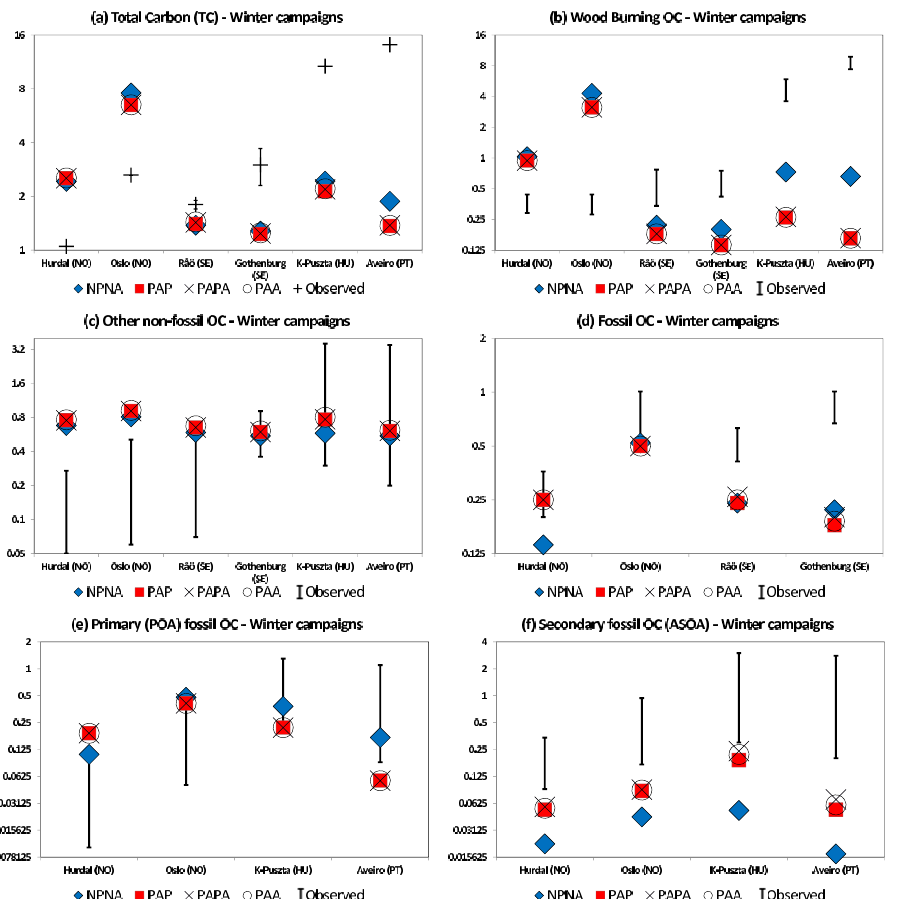
Fig. 11. Source apportionment studies during winter periods (November–April). Comparison of model results to observation-derived values for different source categories of organic carbon and for total carbon (units µg ( C ) m − 3 ). The observed values for the different source cate- gories are based on a statistical approach (Latin-hypercube sampling) and given as 10–90th percentiles (SORGA and G¨ote campaigns: NO and SE stations) or 5–95th percentiles (CARBOSOL campaign: HU and PT stations). Further details, see text and Table